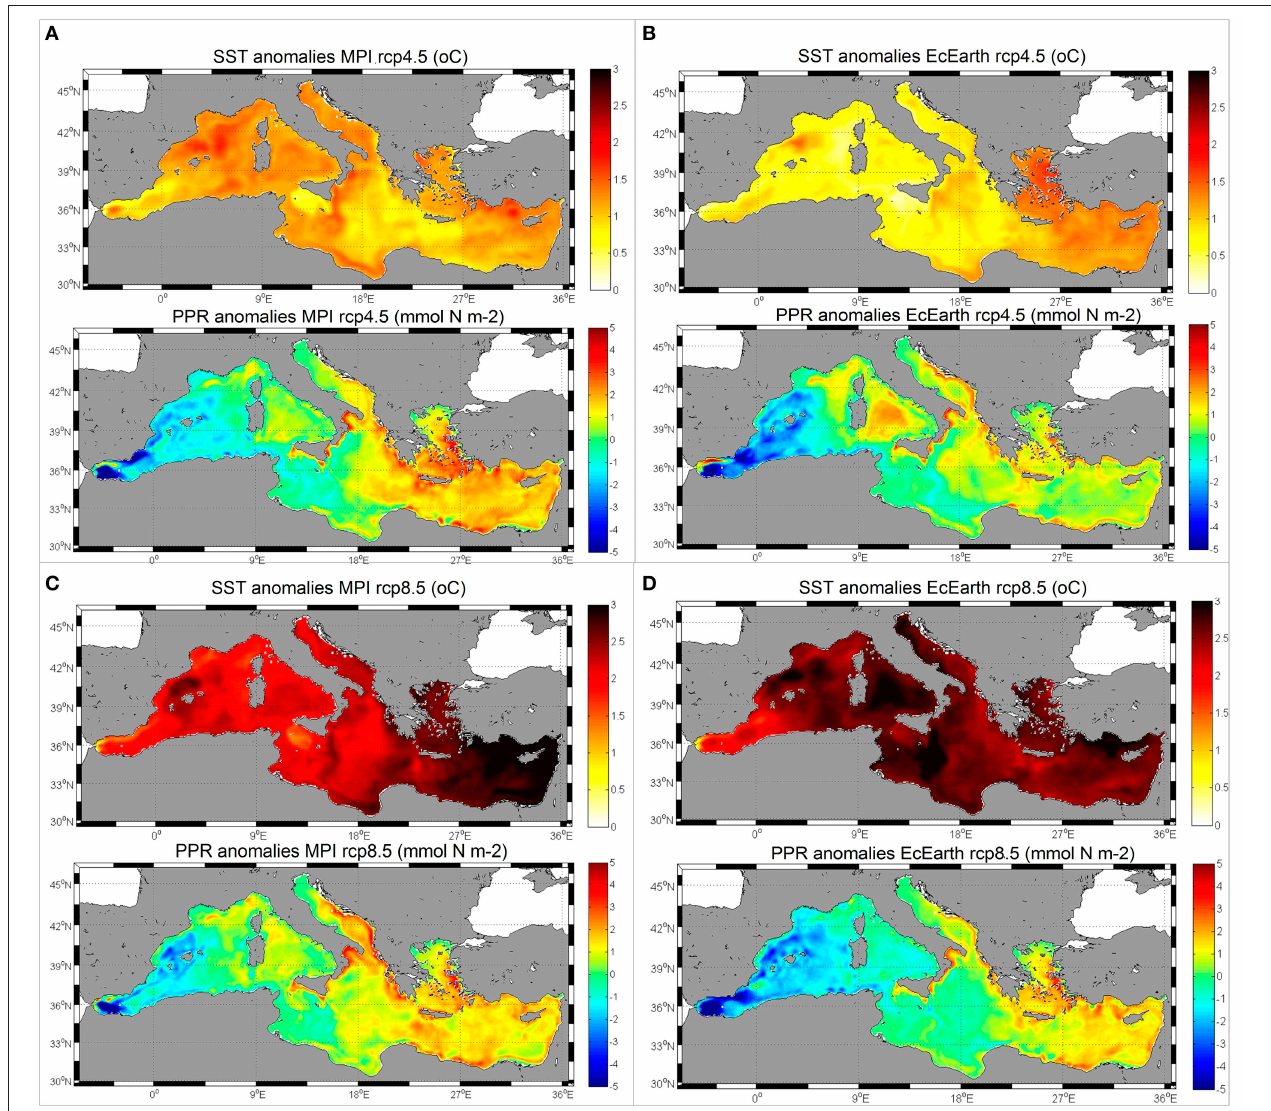
FIGURE 3 | Spatial maps of SST and PPR anomalies (mean from 2095 to 2099minus 2015–2019) for the different scenario runs. (A) MPI rcp45.5, (B) EcEarth rcp4.5, (C) MPI rcp8.5, (D) EcEarth